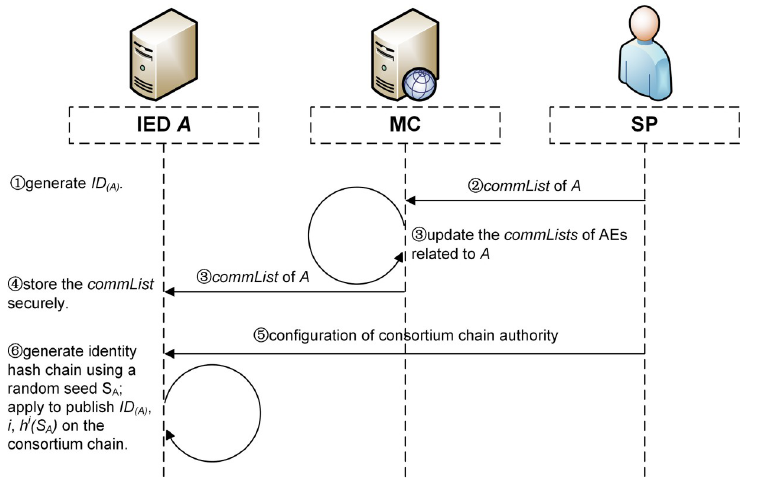
Fig 8. The process of